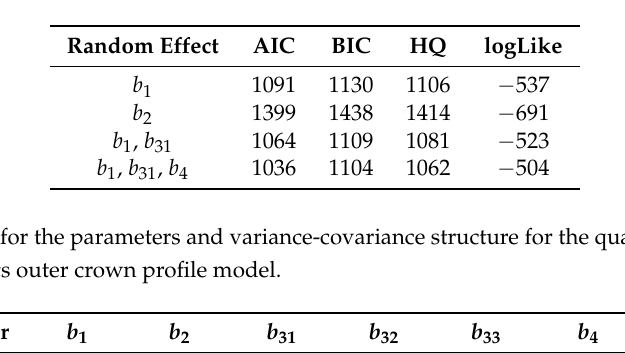
Table 6. Fitting statistics for the quantile regression for linear mixed-effects models of the 0.95th quantile with different random effects parameters.